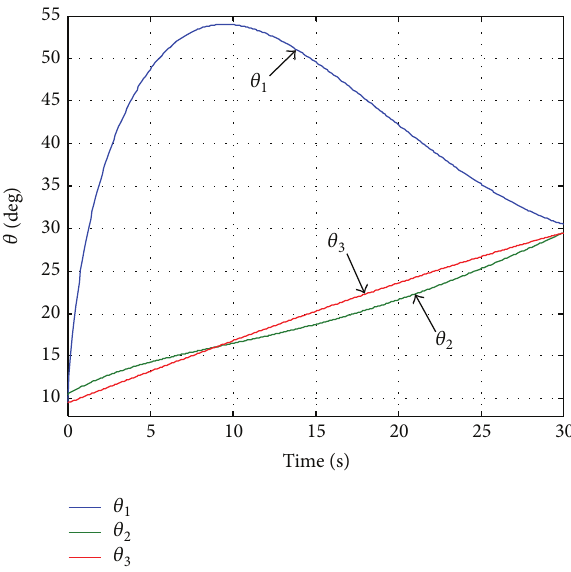
Figure 14: Joint angles displacement with initial errors (simulation 6).